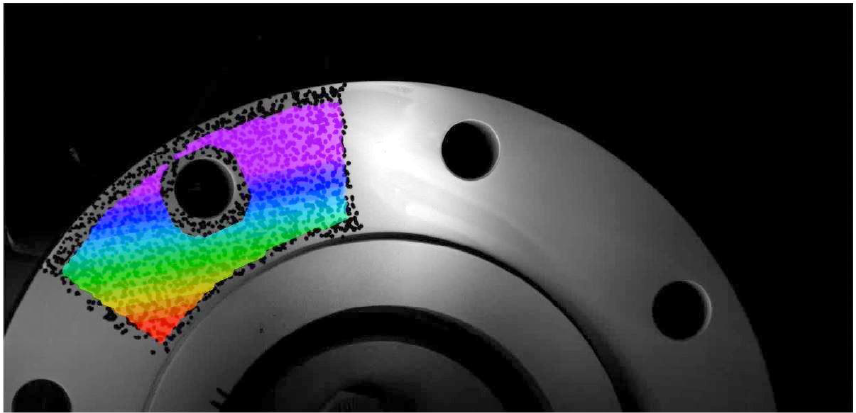
Figure 18. Flange, when the right-hand engine is running, together with the field of linear displace- ment of the area of interest.